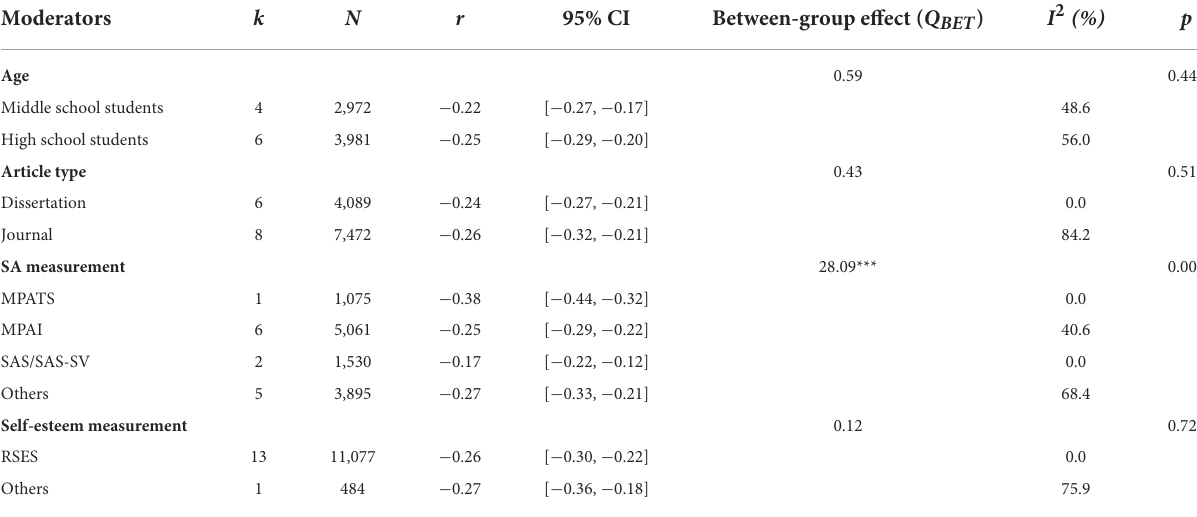
TABLE 3 Subgroup analyses of the summary correlation between smartphone addiction and self-esteem.